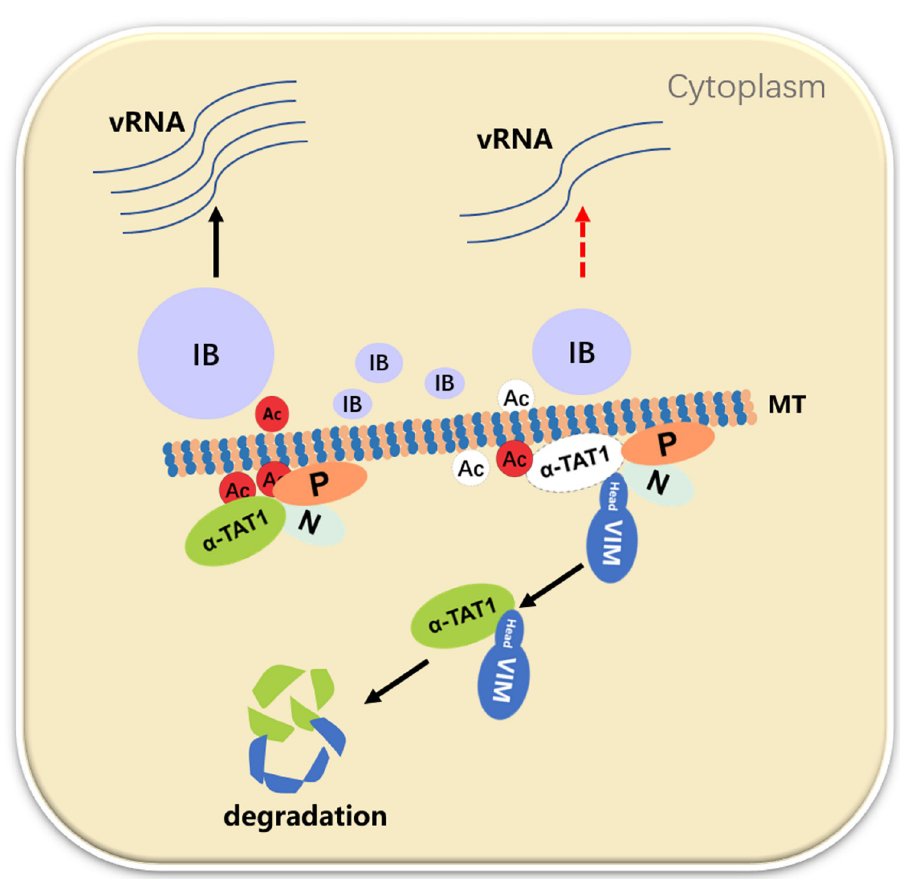
Fig 7. Model of VIM’s inhibitory effect on the fusion of HPIV3 IBs and viral